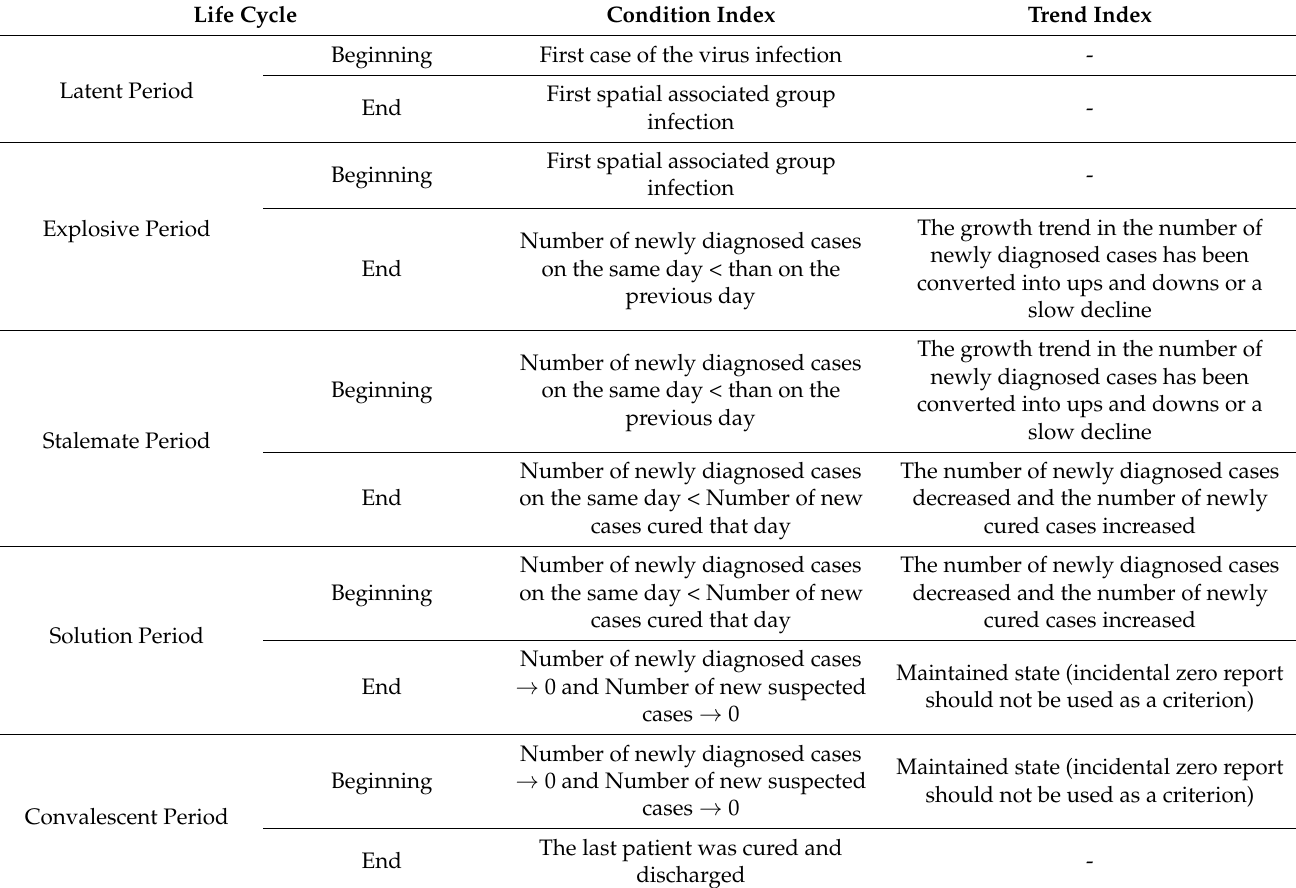
Table 1. Critical standard system for the life-cycle stage division of general infectious